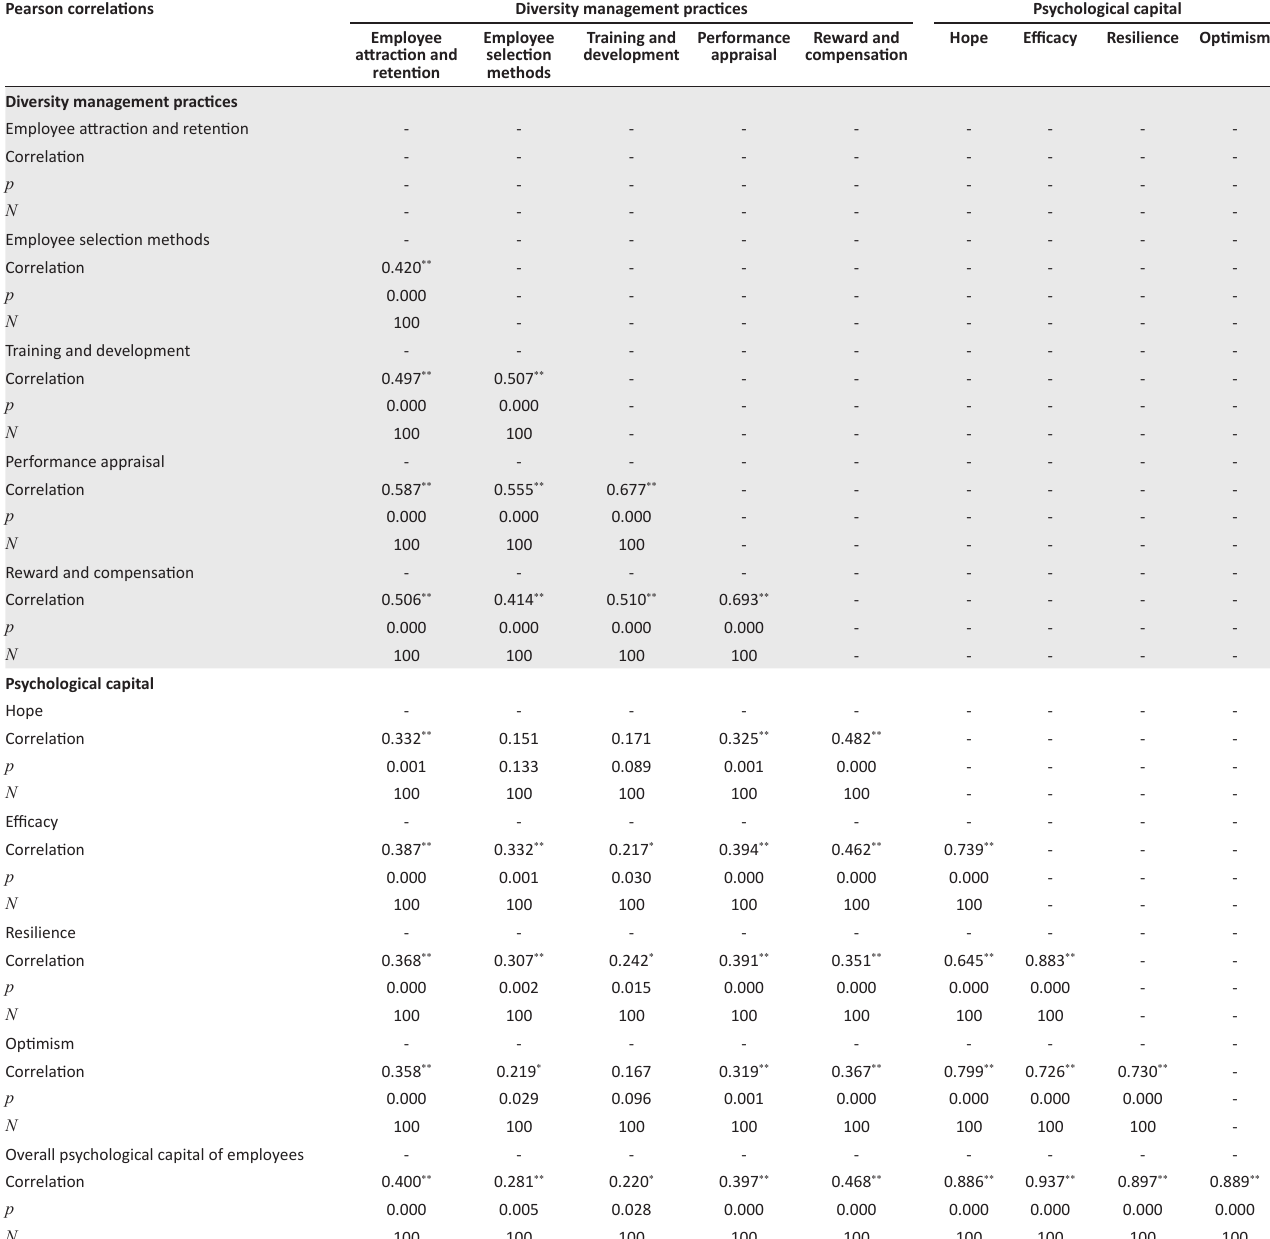
TABLE 18: Correlations of diversity management practices and psychological capital variables. Pearson